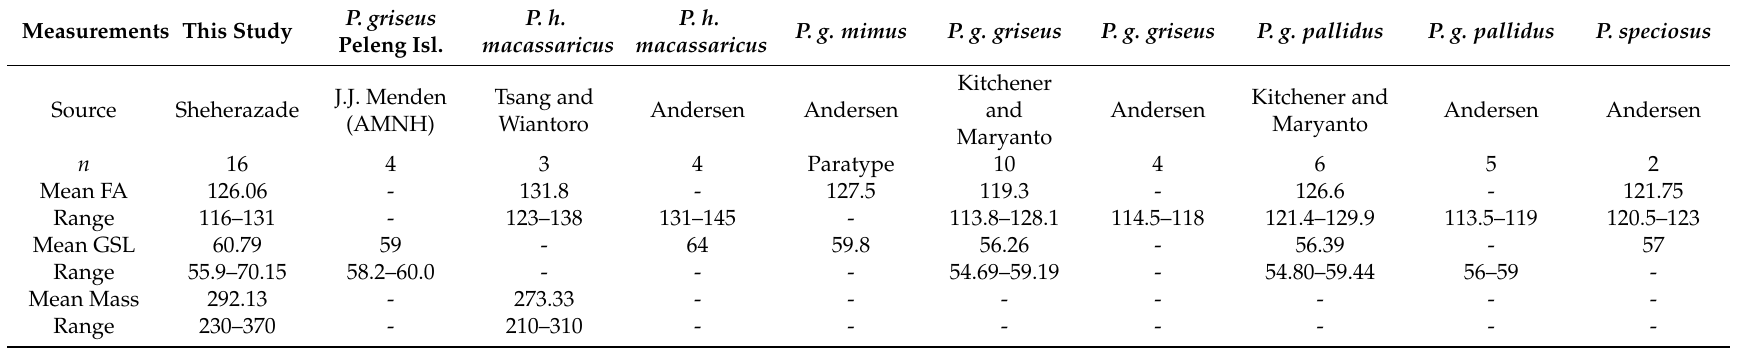
Table 1. Morphological measurements (mean and range) of adult Pteropus griseus captured in Central Sulawesi in this study ( n = 16) compared to other references. One rogue taxa was omitted from the morphological analyses due to its anomalously larger greatest skull length (99.2 mm). All measurements are in millimeters